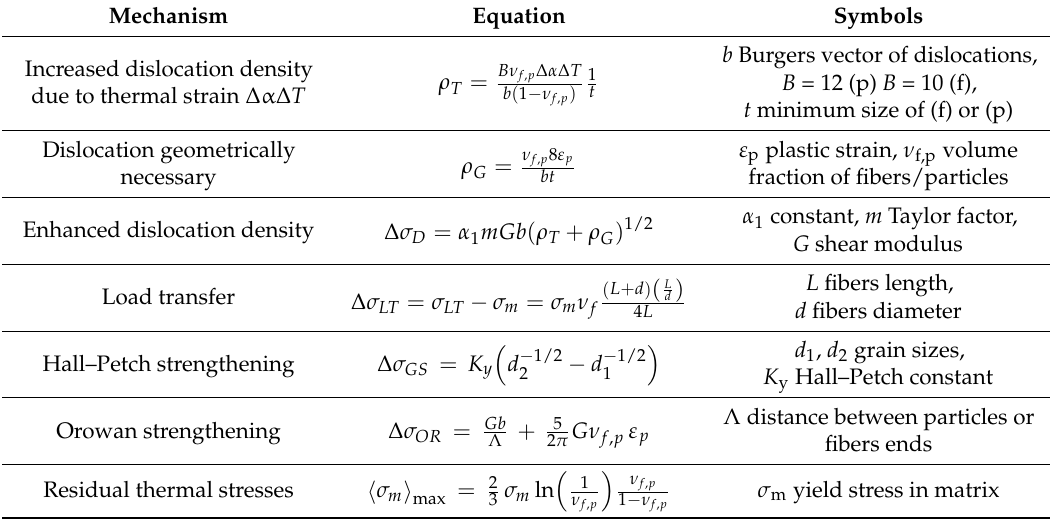
Table 3. Individual contributions to strengthening following from the presence of the reinforcing phase.